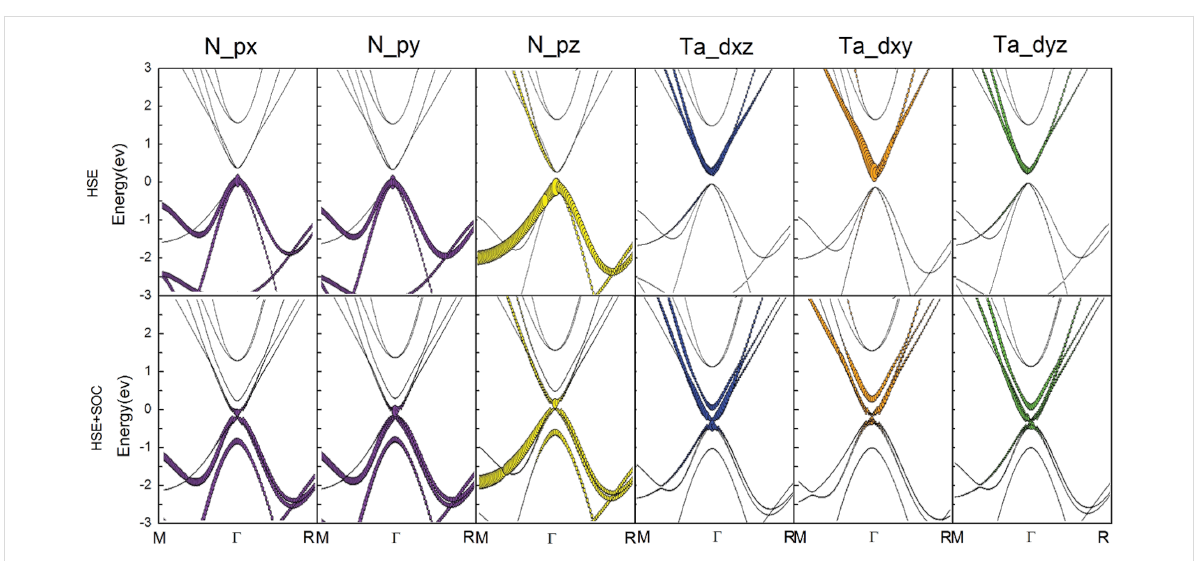
Figure 4: Orbital-resolved band structures for ThTaN 3 under 5% compressive strain as calculated by the HSE (top panel) and HSE+SOC methods (bottom panel). The contributions are mainly from p x , p y , p z of N atoms and d xz , d xy , d yz of Ta atoms. The thicker and thinner lines account for large and low orbital contributions,